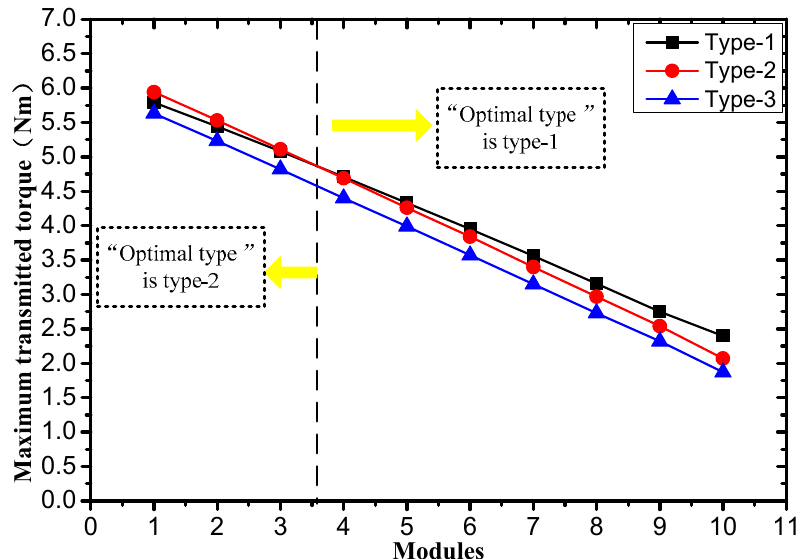
Modules T of each module of C-HPMC. Figure 7. max Table 4. T max of C-HPMC based on “optimal type selection” method. T of C-HPMC based on “optimal type selection” method. Magnetization Type of HPMC T max max